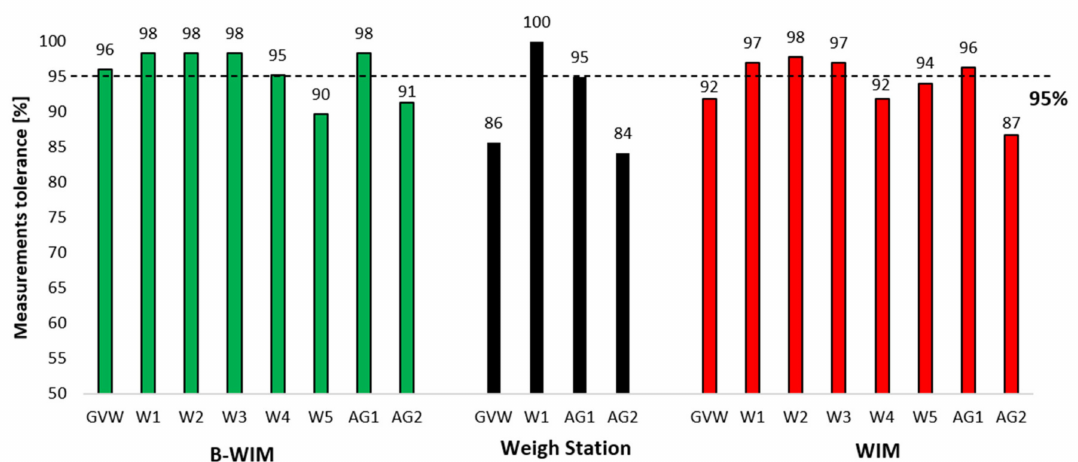
Figure 10. Measurement tolerances compared to portable scales.